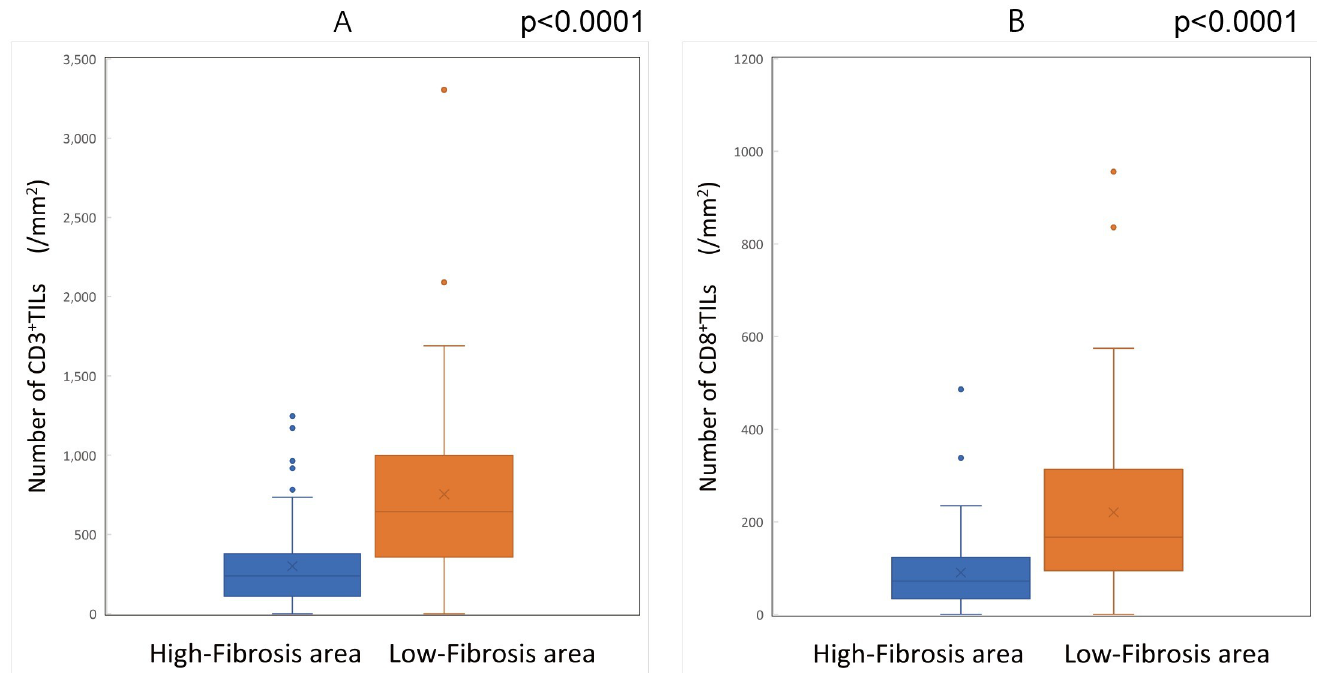
Fig 13. The comparison of the density of tumor-infiltrating lymphocytes in high-/low-fibrosis areas. (A) The density of CD3-positive tumor-infiltrating lymphocytes in the high-fibrosis area was significantly lower than that in the low-fibrosis area (p < 0.0001). (B) The density of CD8-positive tumor-infiltrating lymphocytes in the high-fibrosis area was significantly lower than that in the low-fibrosis area (p < 0.0001).